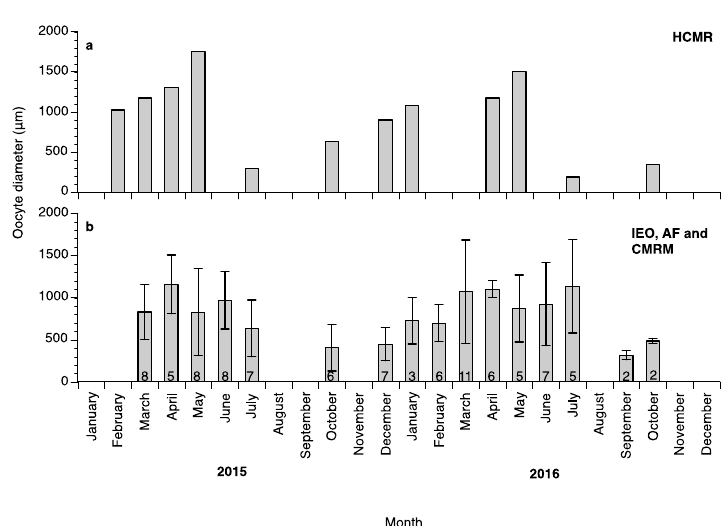
Figure 3. Mean (±standard deviation (SD)) oocyte diameters of a wreckfish from the Hellenic Center for Marine Research (HCMR), Greece ( a ) and from three different broodstocks in Spain ( b ) during the annual reproductive cycles in 2015 and in 2016. The numbers inside the bars indicate the number of females biopsied at each month. IEO: Instituto Español de Oceanografía, AF: Aquarium Finisterrae, CMRM: Conselleria do Medio Rural e Mariño.